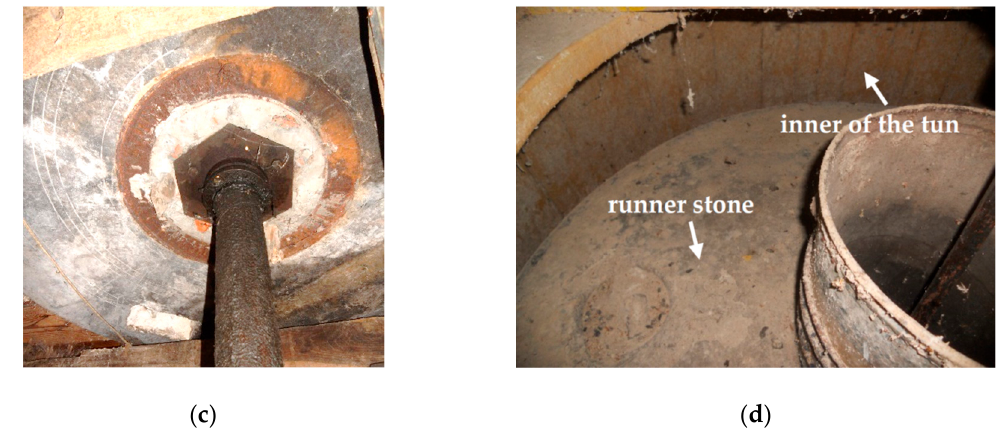
Figure 17. Coupling between the shaft C and runner stone: ( a ) Shaft C (Riviera mill); ( b ) runner stone (Riviera mill); ( c ) shaft C (Forno mill); ( b ) runner stone (Forno mill).